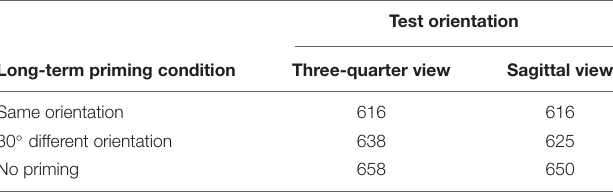
TABLE 2 | Mean identification time (in ms) of anatomically possible human postures in the test phase of Experiment 2 as a function of long-term priming condition and test